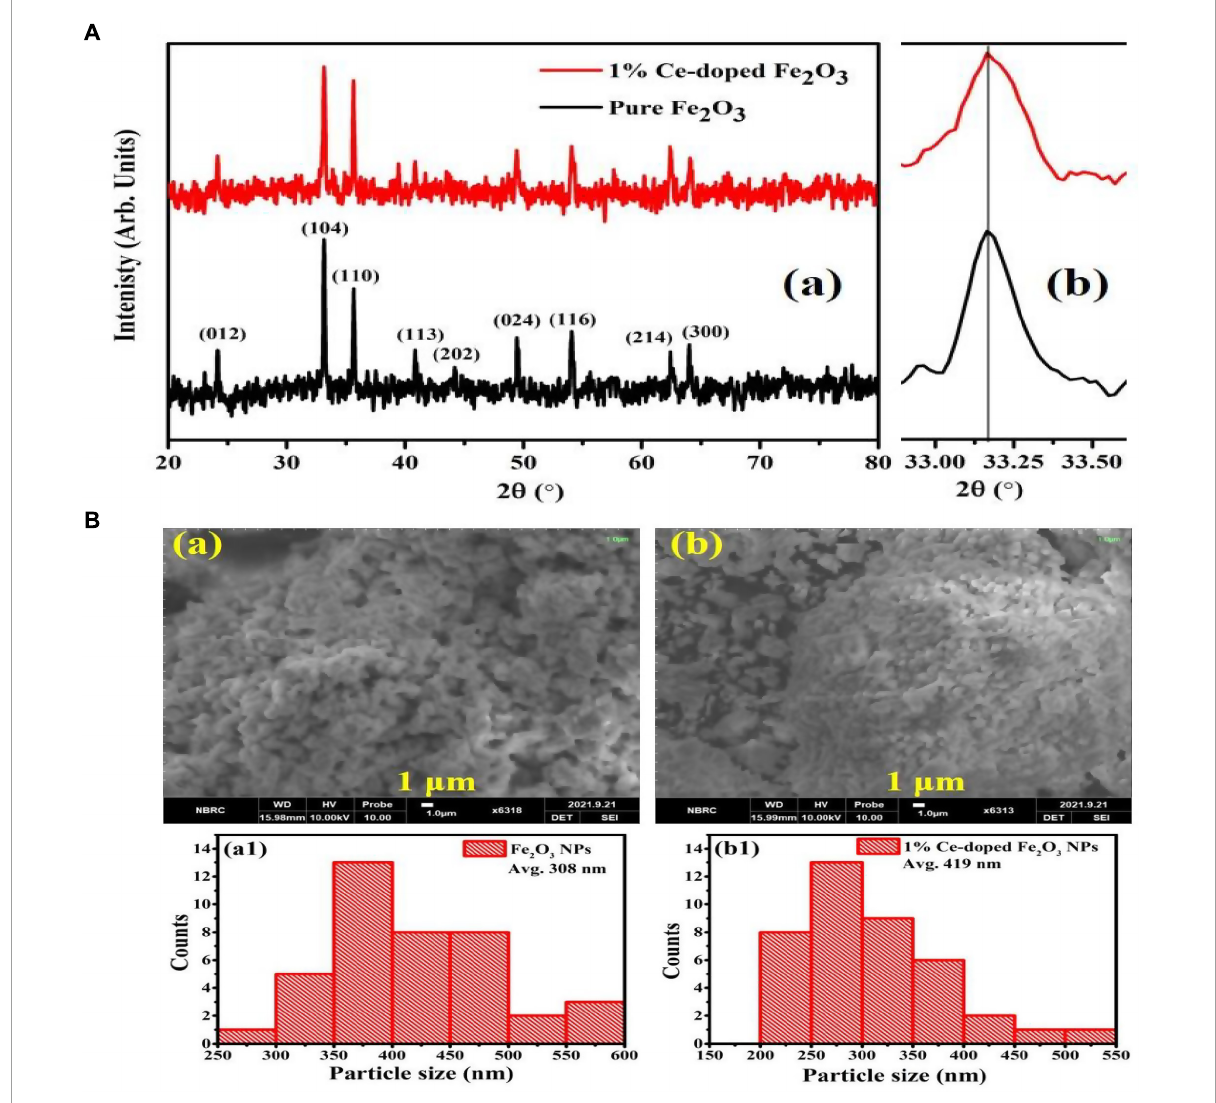
FIGURE1 (A) X-ray diffraction profiles of undoped Fe 2 O 3 and Ce-doped Fe 2 O 3 nanoparticles synthesized by auto combustion method using oxalic acid (a). Slight shifting of Fe 2 O 3 (104) peak, to lower 2 θ angles, is due to Ce-atoms doping (b). (B) SEM images of pure Fe 2 O 3 (a) and 1% Ce-doped Fe 2 O 3 NPs (b). Particle size distributions of pure Fe 2 O 3 (a1) and 1% Ce-doped Fe 2 O 3 NPs